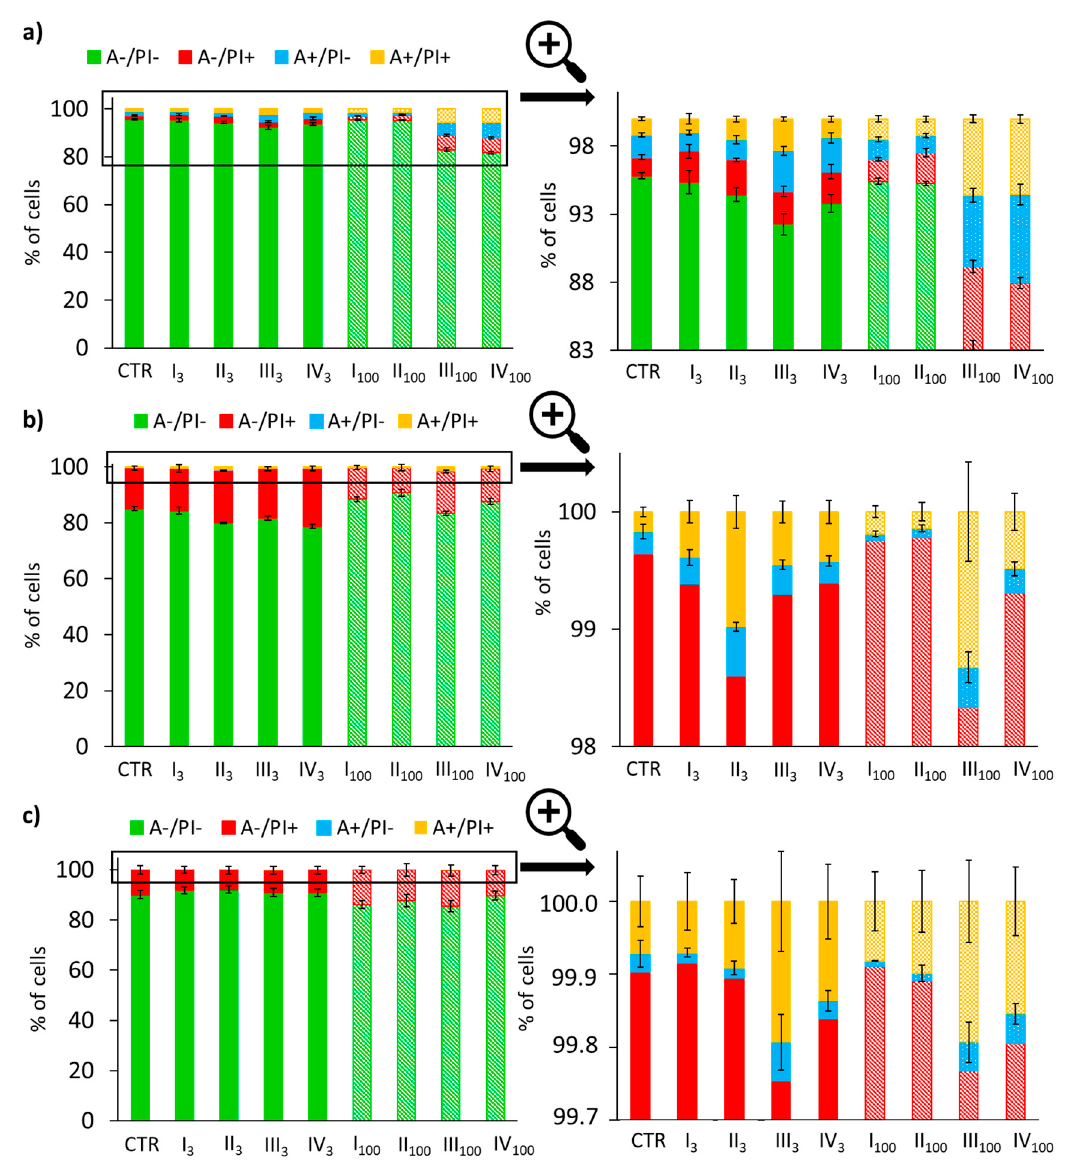
Figure 8. Results of Annexin V / PI double staining apoptosis assay in NHDF ( a ), HaCaT ( b ), and Me45 ( c ) cells after carrier solution additions at concentrations of 3 µ g / mL and 100 µ g / mL, followed by 72 h of incubation, where A − / PI − : live cells; A − / PI + : necrosis; A +/ PI − : early apoptosis; A +/ PI + : late apoptosis; 3—3 µ g / mL, 100—100 µ g / mL. Means ± S.D. from three independent